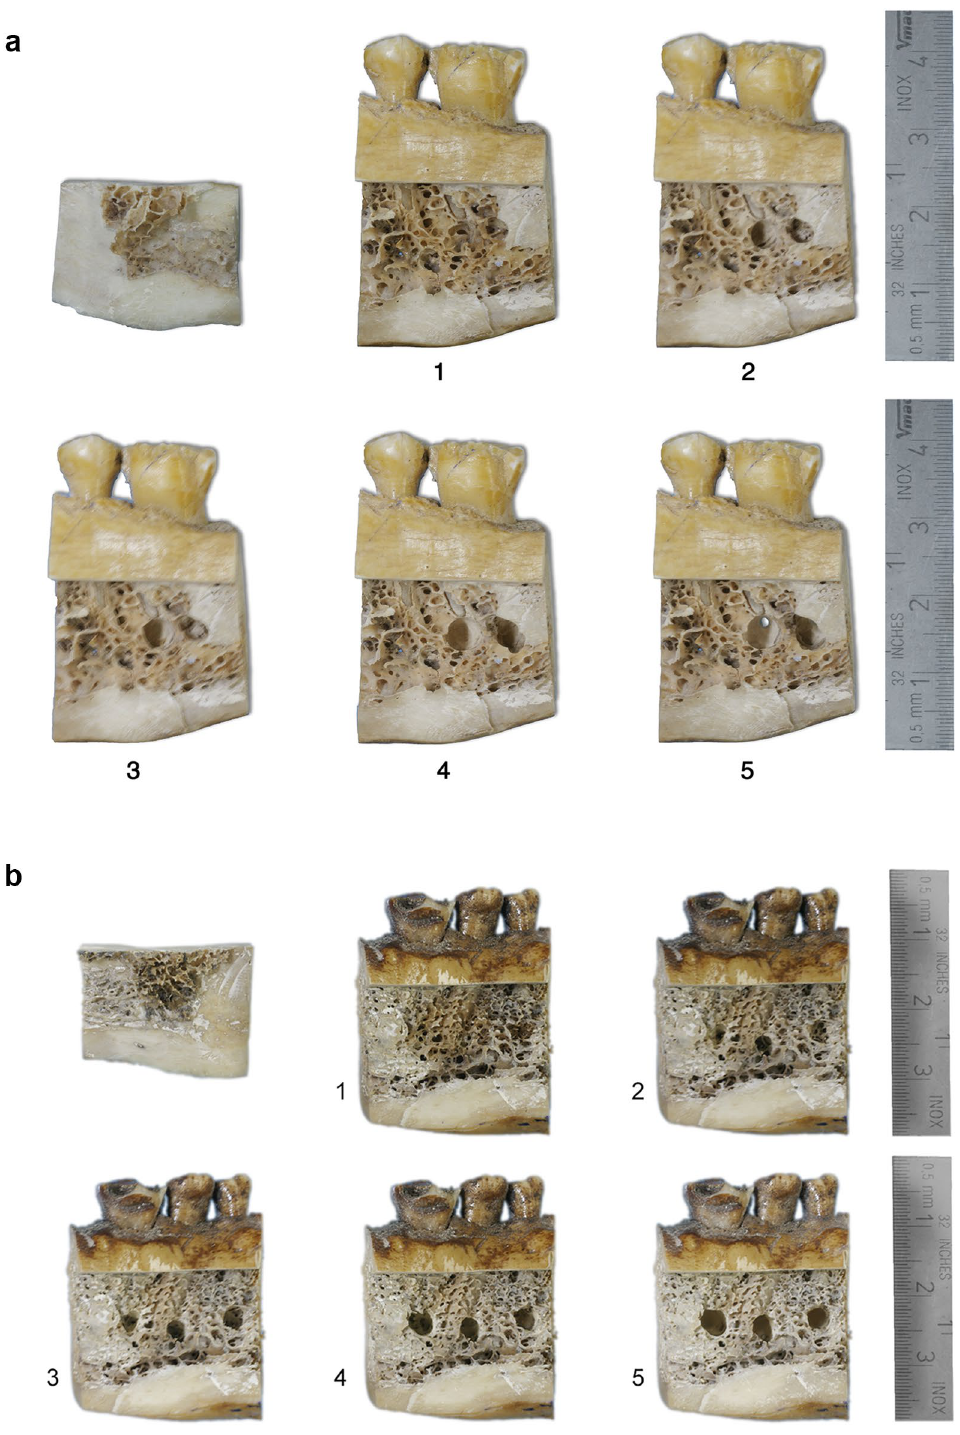
Figure 2. ( a ) Access to the apical region obtained through the design of a cortical plate (upper left) that could be repositioned without any interference. The SALs preparation at different stages (Table 1; 1 = no lesion; 2 = 50% of the bur diameter in cancellous bone; 3 = 100% of the bur diameter in cancellous bone; 4 = complete cancellous bone width; 5 = cortical bone perforated) can be observed from specimens one (no lesion) to five. ( b ) Access to the apical region obtained through the design of a cortical plate (upper left) that could be repositioned without any interference. The SALs preparation at different stages (Table 1; 1 = no lesion; 2 = 30% of the bur diameter in cancellous bone; 3 = 50% of the bur diameter in cancellous bone; 4 = 100% of the bur diameter in cancellous bone; 5 = complete cancellous bone width) can be observed from specimens one (no lesion) to